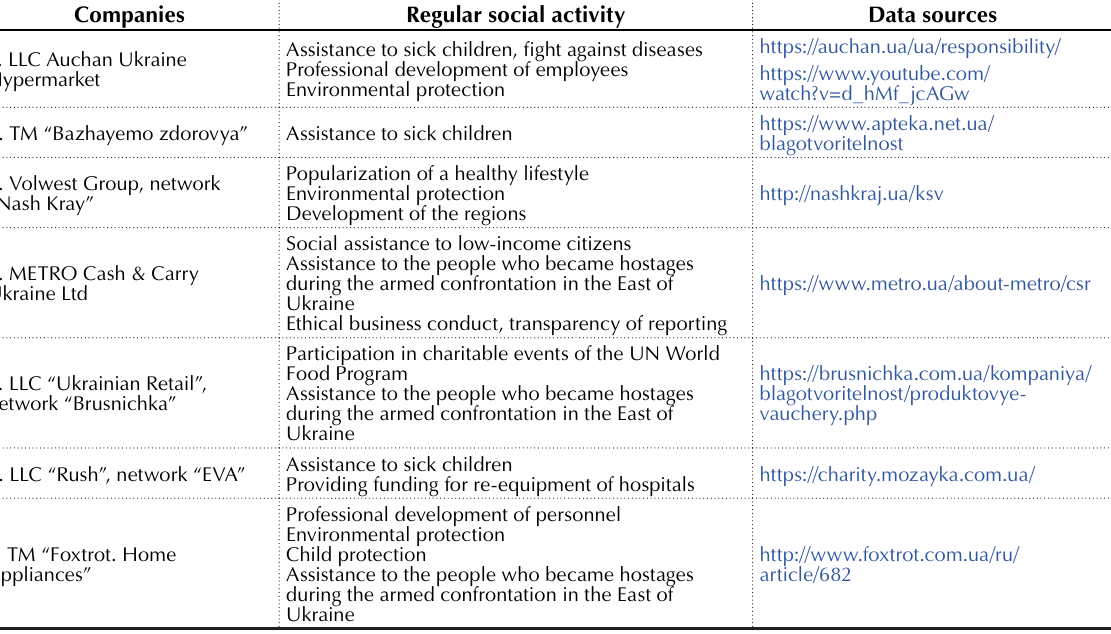
Source: compiled by the authors according to the companies’